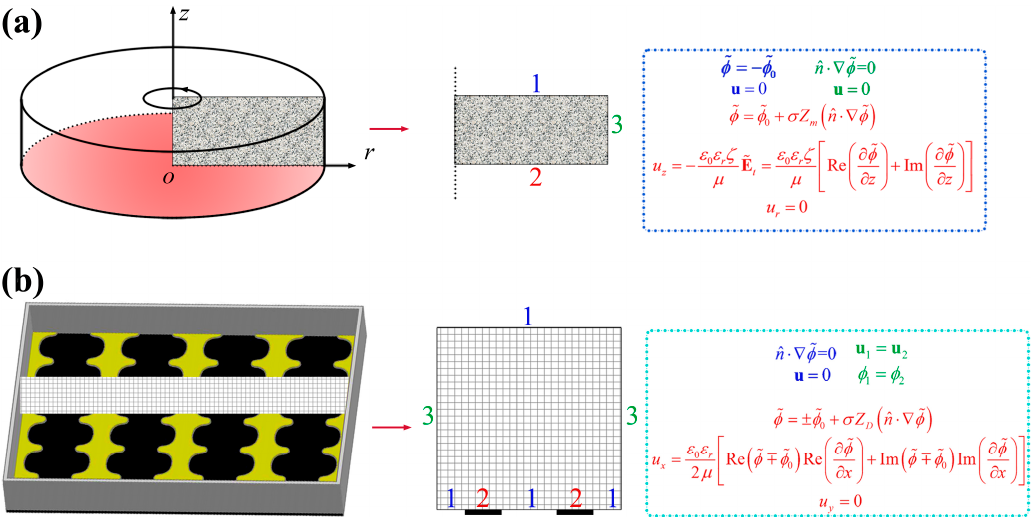
Figure 6. The schematic diagrams of the 3D ( a ) and 2D ( b ) electrode system, and their corresponding boundary conditions.